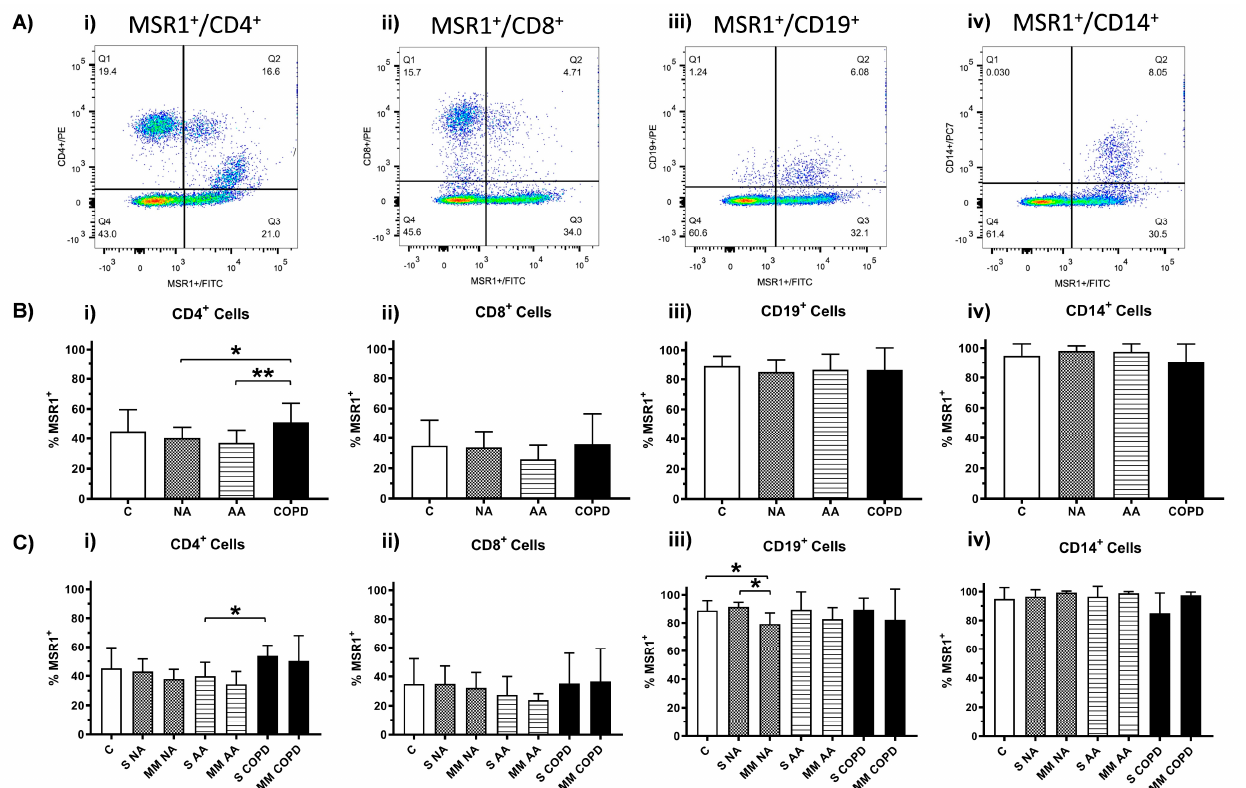
Figure 4. Expression of MSR1 on cell subpopulations of PBMCs. C: Control ( n = 11), NA: Nonallergic Asthma ( n = 11), AA: Allergic Asthma ( n = 13), COPD ( n = 11), S: severe diagnosis; MM: moderate–mild diagnosis. ( A ) Representative example of the results obtained in cell subpopulation PBMCs analysis: ( i ) MSR1 + CD4 + double positive cells; ( ii ) MSR1 + CD8 + double positive cells; ( iii ) MSR1 + CD4 + double positive cells; and ( iv ) MSR1 + CD4 + double positive cells. ( B ) Expression of MSR1 + cells by clinical groups. Mean percentages of MSR1 + cells within ( i ) CD4 + subpopulation, ( ii ) CD8 + subpopulation, ( iii ) CD19 subpopulation, and ( iv ) CD14 + subpopulation. ( C ) Mean percentages of total MSR1 + cells according to disease severity. Mean percentages of MSR1 + cells within ( i ) CD4 + subpopulation, ( ii ) CD8 + subpopulation, ( iii ) CD19 subpopulation, and ( iv ) CD14 + subpopulation. *,** Statistically significant differences ( p < 0.05, p < 0.005, and p < 0.001, respectively) between the indicated groups.